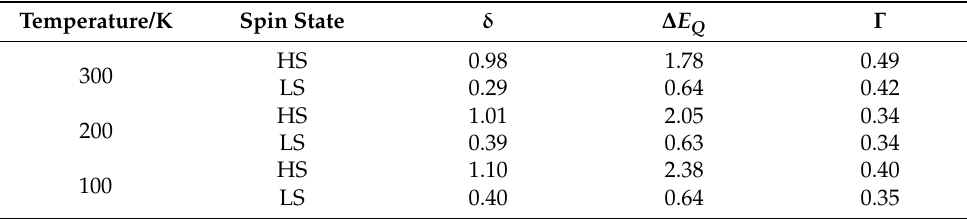
Figure 6. Mössbauer spectra of compound 2 , at 300 K ( top ), 200 K ( middle ) and 100 K ( bottom ). Experimental data are in black dots and the lines are data fitted, giving the parameters listed in Table 2. Fitting curves are low-spin (blue), high-spin (green) and total (red). Table 2. Fitting parameters for variable temperature Mössbauer spectra 1 for compound 2